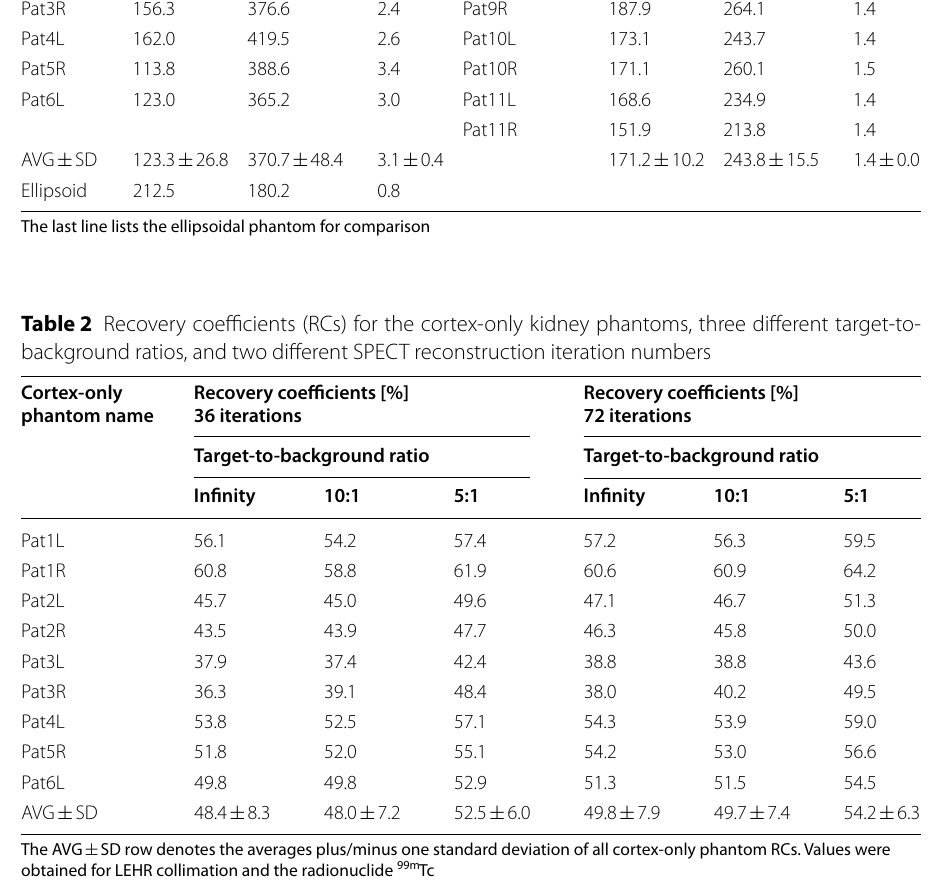
for the two types of kidney phantoms. The SA:V ratio in the cortex-only and whole- parenchyma phantoms averaged 3.0 cm − 1 and 1.4 cm − 1 , respectively. The elliptical refer- ence phantom had a volume of 212.5 cm 3 , a surface area of 180.2 cm 2 , and a SA:V ratio of 0.8 cm − 1 . Table 1 lists the volume, surface area, and SA:V ratio for each phantom. Recovery coefficients